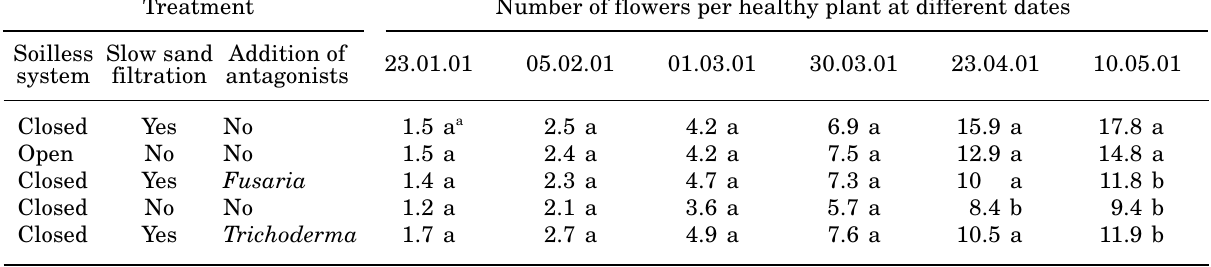
Table 7. The effect of selected strains of Fusarium and Trichoderma on the production of flowers per healthy gerbera plant grown in different closed soilless systems (Albenga, 2001).